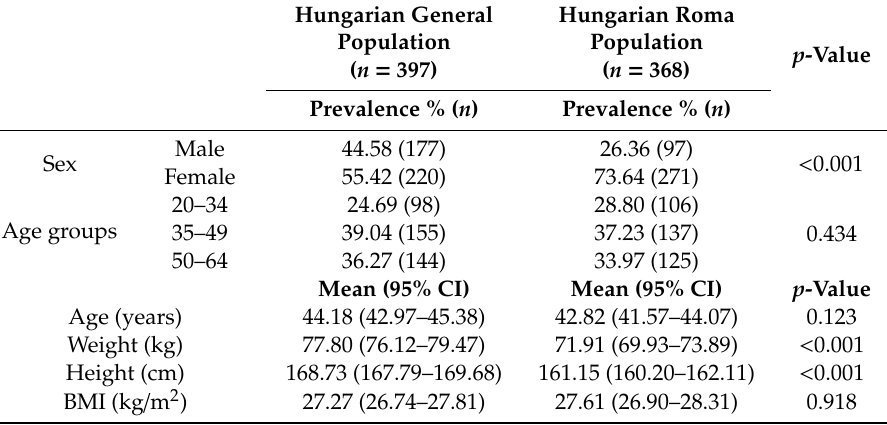
Table 1. Anthropometric and demographic characteristics of the study